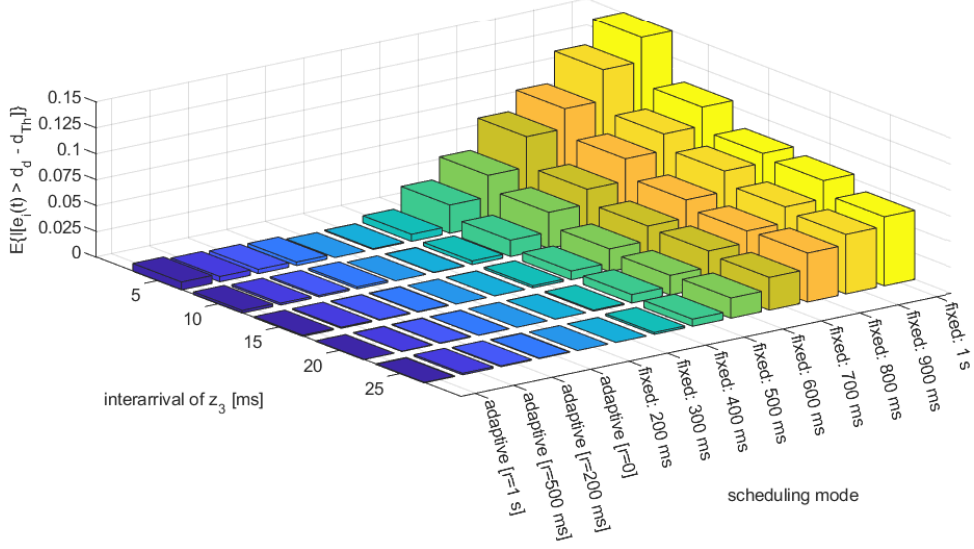
Figure 7. Fraction of emergency braking distance violations per simulation run (700 s) vs. selected transmission period and mean inter-arrival of z 0 random